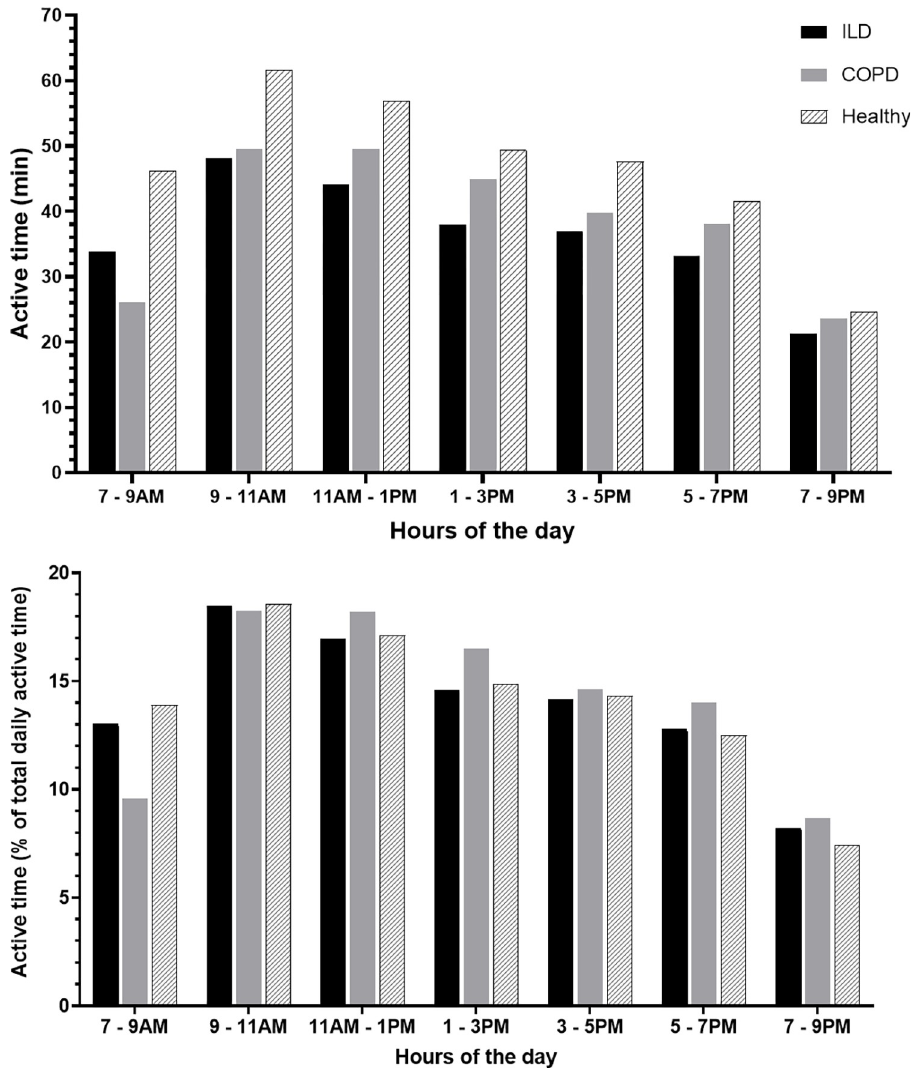
Fig 2. Absolute and relative active time per day in patients with ILD, COPD and healthy controls. Distribution of active periods (METs level � 1.5) in a day, expressed as the amount of active minutes per two hours (panel A) and the relative distribution of a patient’s active time over the day during waking hours (7AM to 9PM) (panel B) in patients with ILD, COPD and healthy controls.